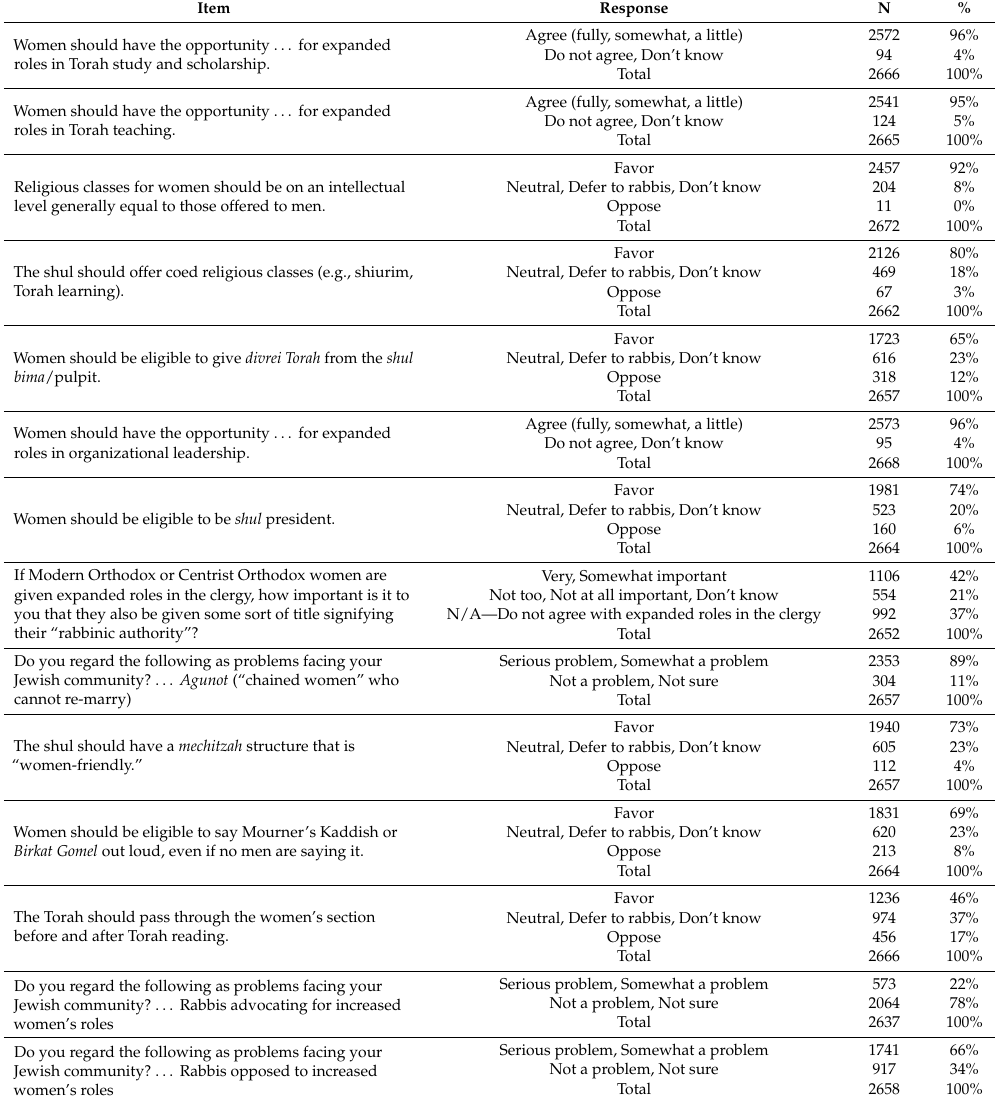
Table 2. Observed variables for latent class